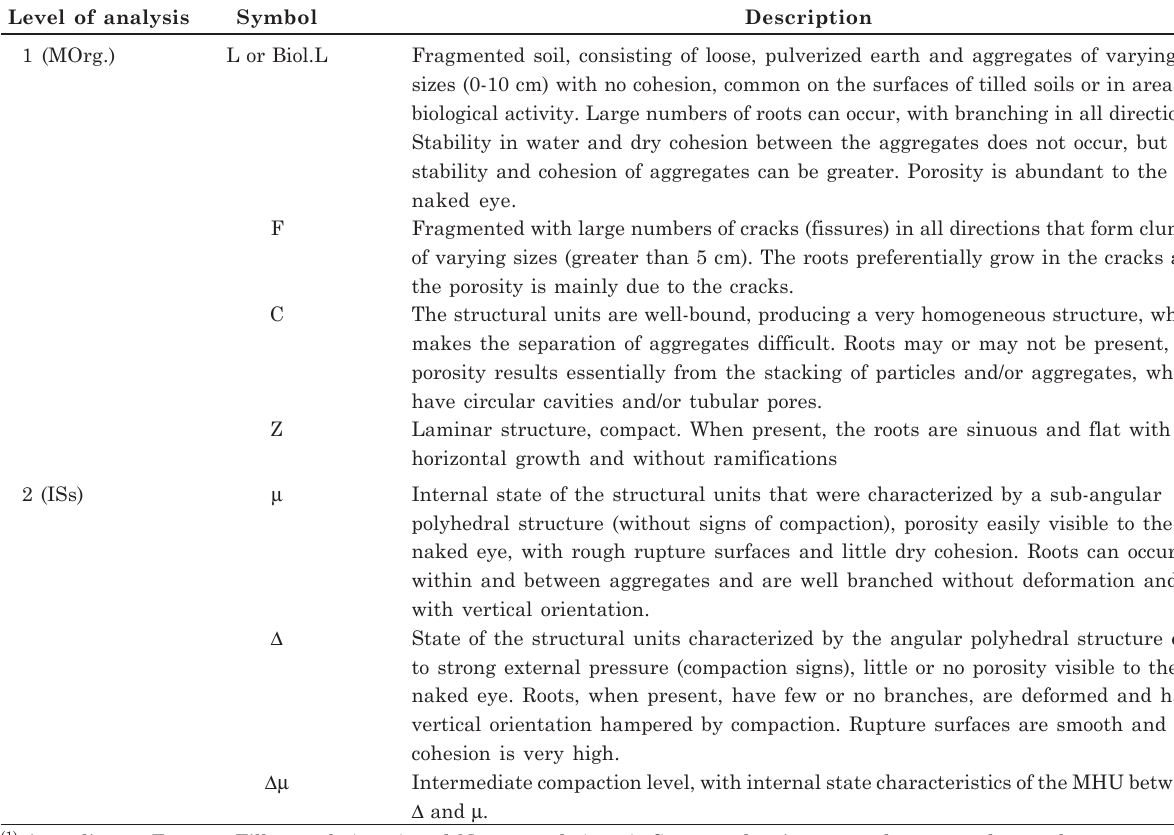
Table 2. Mode of organization and internal state of the structural units (1) determined by the crop profile method